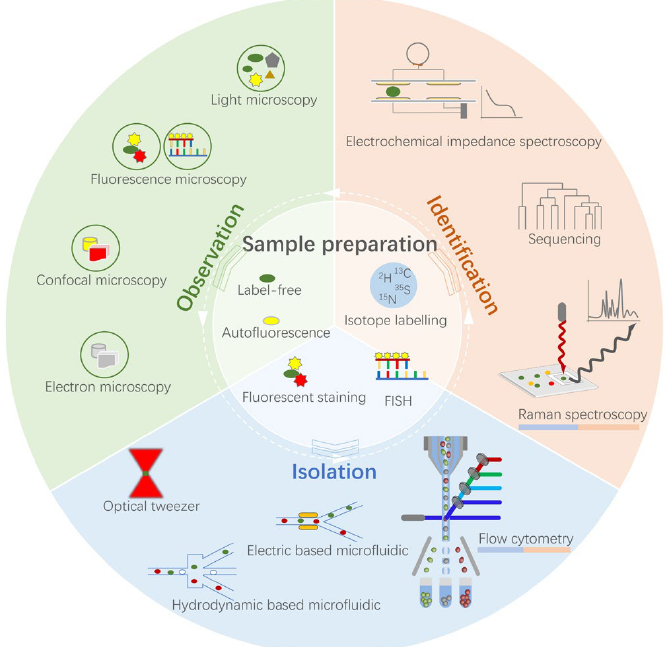
Figure 2. Workflow for single-cell analysis in terms of observation, identification, and isolation of cells at the single-cell level. Sample preparation mainly includes label-free, autofluorescent, and fluorescently stained cells, isotope-labeled cells, and FISH-labeled cells. Observation of single cells mainly uses light microscopy, fluorescent microscopy, confocal microscopy, and electron microscopy. Identification of single cells can be achieved by sequencing, electrochemical impedance spectroscopy, and Raman spectroscopy. Isolation of targeted single cells can be performed through optical tweezers, microfluidic chips, and flow